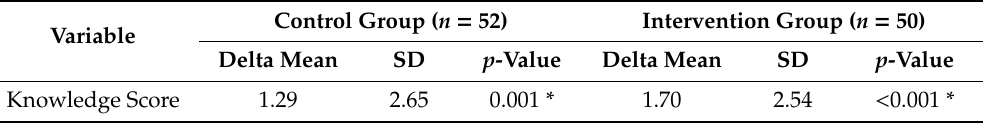
Table 8. Change in children’s knowledge of the importance of fish consumption after 3 months of